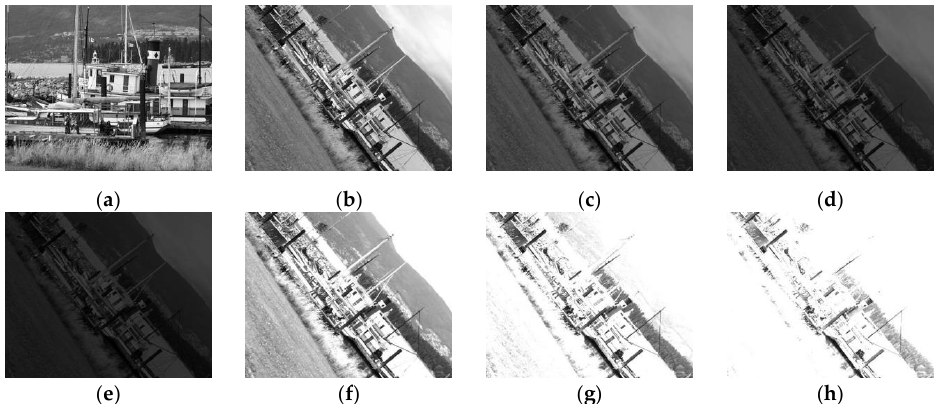
Figure 6. Boat sequence. ( a ) Normal Boat; ( b ) New Boat with a scale reduction factor of 1.9 and a rotation angle of 45 degrees; ( c ) New Boat in an underexposure of –1; ( d ) New Boat in an underexposure of –2; ( e ) New Boat in an underexposure of –3; ( f ) New Boat in an overexposure of +1; ( g ) New Boat in an overexposure of +2; ( h ) New Boat in an overexposure of +3.